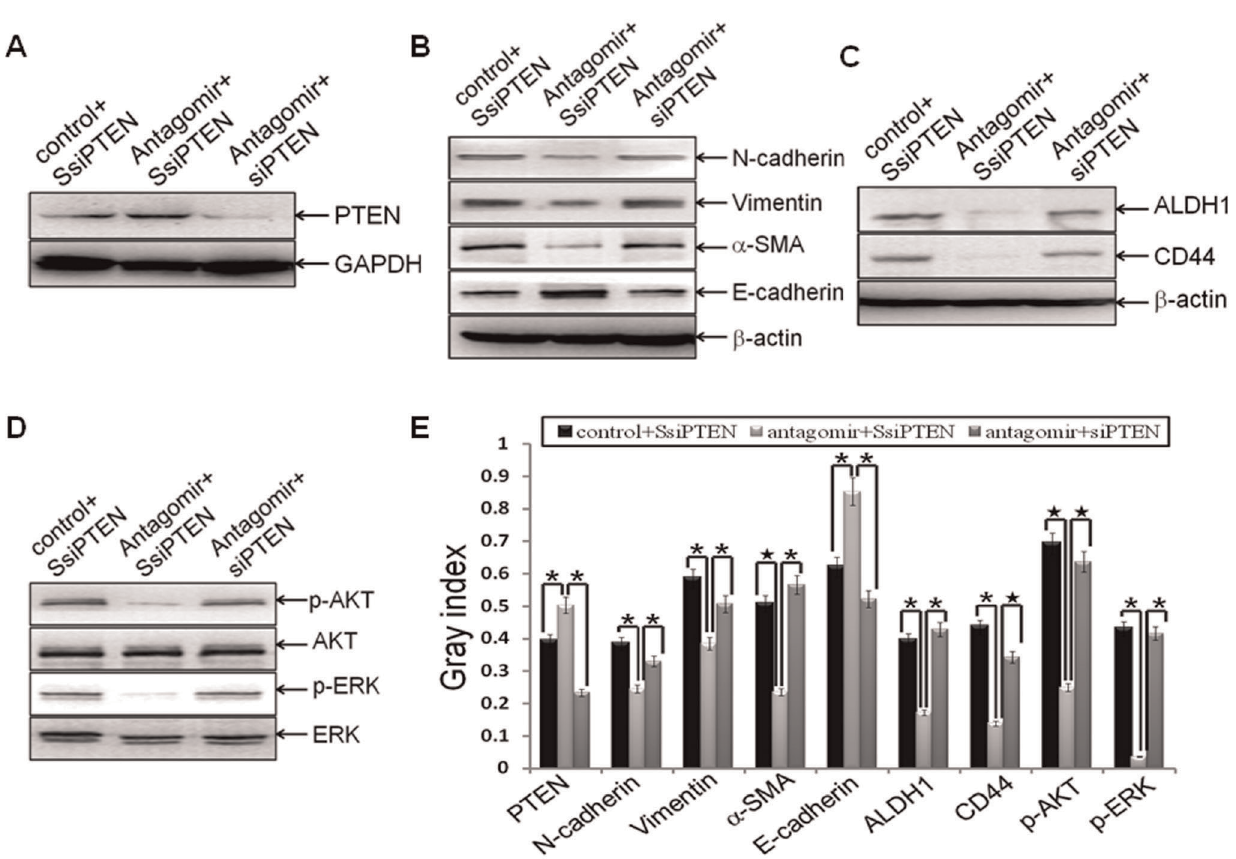
Figure 5. PTEN was the downstream target of miR-21 during reversing EMT and CSC phenotype . MDA-MB-231 cells were transfected with siPTEN or the scrambled control SsiPTEN at a final concentration of 50 nmol for 24 h. Then the cells were transfected with hsa-miR-21 antagomir or negative control at a final concentration of 50 nmol for 72 h. Cells were trypsinized, and the relative protein levels of PTEN (A), EMT markers (B), CSC surface markers (C), p-AKT and AKT (D), as well as p-ERK and ERK (D) were measured and semi-quantified (E) as stated before. The representative plugs from treatments of SsiPTEN plus miR-21 antagomir control, SsiPTEN plus miR-21 antagomir, and siPTEN plus miR-21 antagomir were shown in the picture. Beta-actin or GAPDH was used as loading control. (*indicates p , 0.05; w indicates p , 0.001).